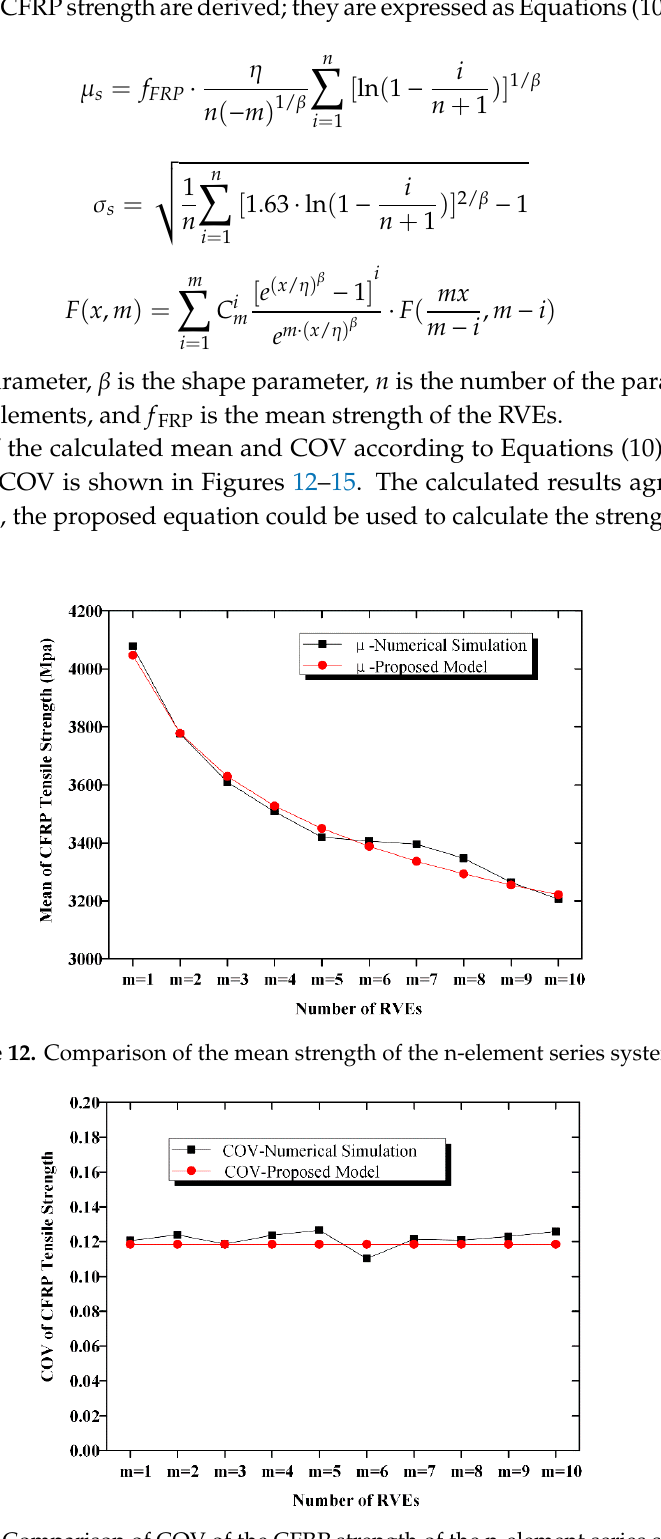
Figure 13. Comparison of COV of the CFRP strength of the n-element series system.